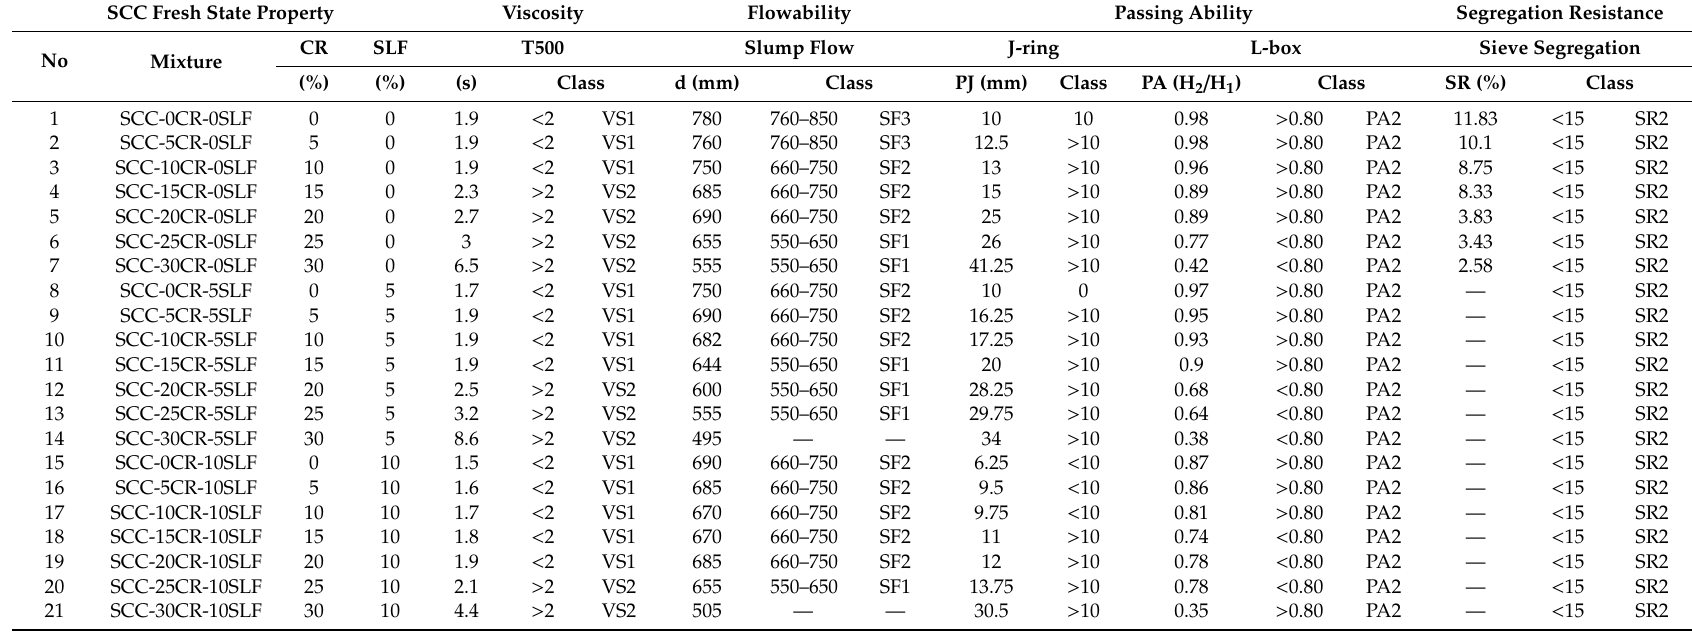
Table 6. Test results of fresh SCC